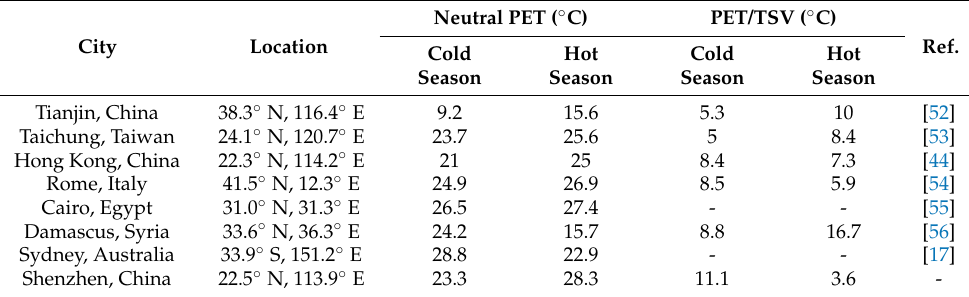
Table 16. Neutral PET and PET/TSV for Tianjin, Taichung, Hong Kong, Rome, Cairo, Damascus, Sydney and